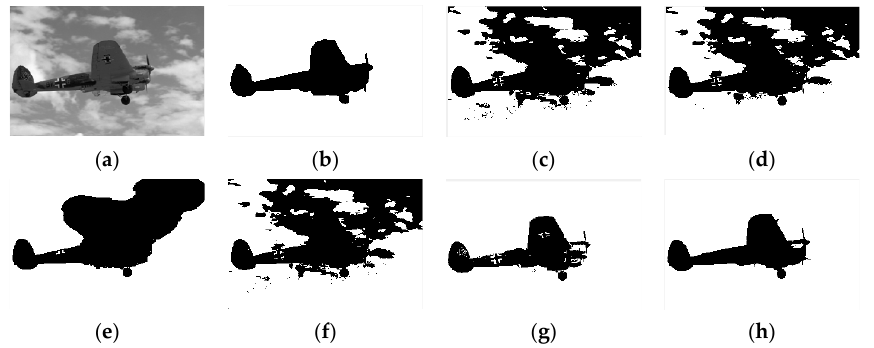
Figure 11. #3063 and its segmentations: ( a ) #3063, ( b ) ground-truth, ( c ) Otus, ( d ) MRCUT, ( e ) EITMIS, ( f ) NSWCC, ( g ) IT2FSWCC, ( h ) FSEFTISRI.